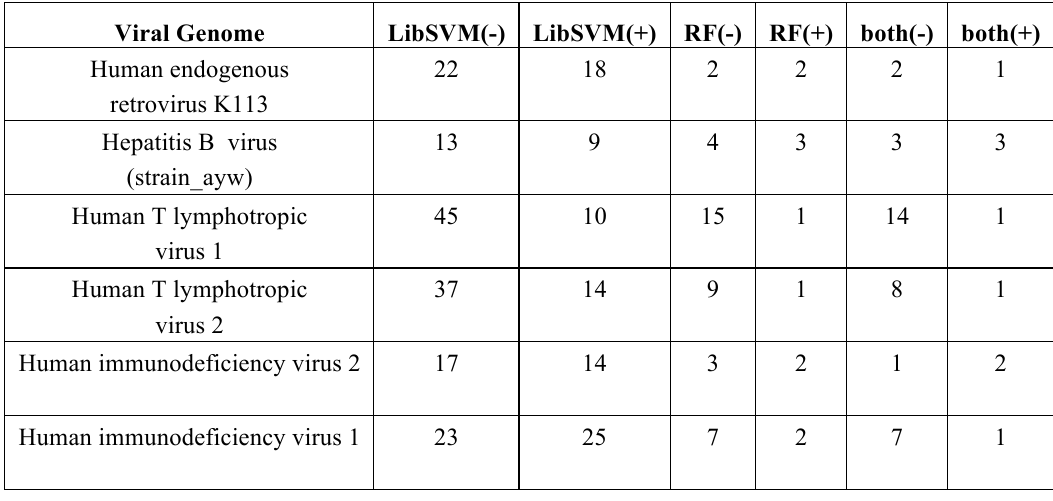
Table 1: Number of predicted hairpins in 5 virus genomes by using models learned from known virus hairpins. RF: random forest, + and - indicate strands. Prediction score cut-off value is 0.95.